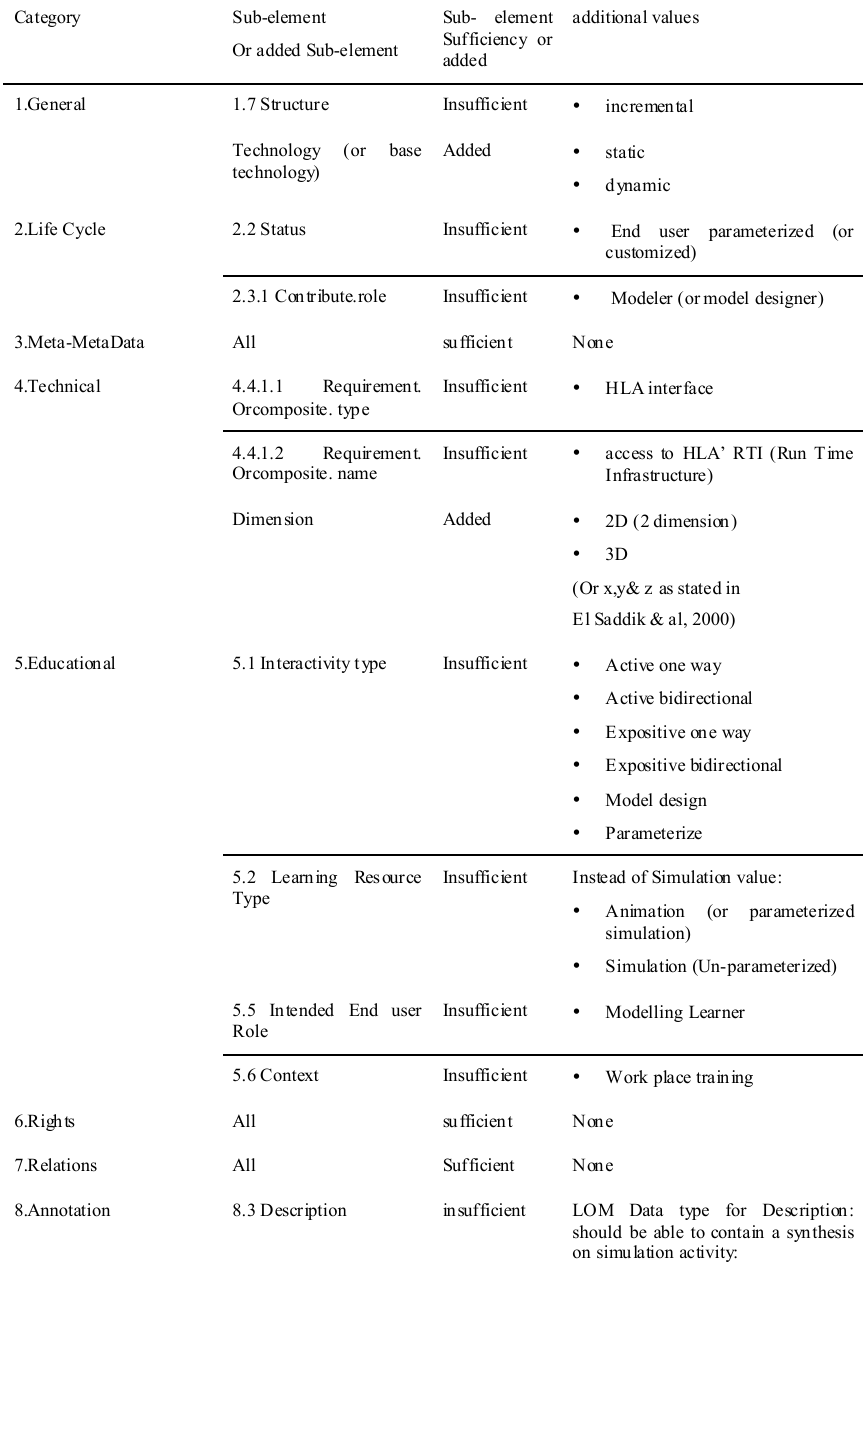
Table 2. LOM model update proposal